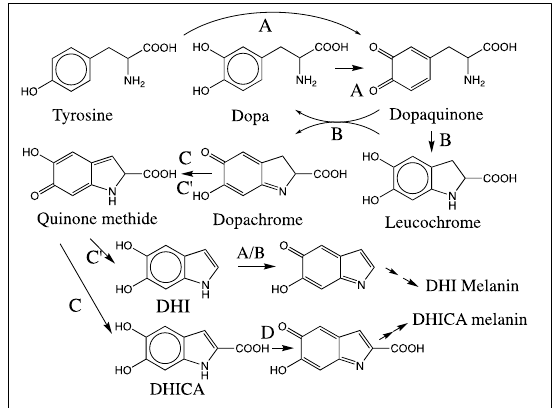
Figure 1. Simplified mechanism for eumelanin biosynthesis. Tyrosinase ( A ) oxidizes both tyrosine and dopa to dopaquinone. Dopaquinone undergoes a nonenzymatic intramolecular cyclization reaction to form leucochrome, which, following redox exchange with dopaquinone itself, produces dopachrome and dopa. Insect dopachrome decarboxylase/tautomerase ( C’ ) converts dopachrome to DHI. Mammalian dopachrome tautomerase ( C ) converts dopachrome to DHICA. In mammals, DHI seems to be produced nonenzymatically; in insects, DHICA is apparently not being formed. Oxidative polymerization of DHI and DHICA generates eumelanin pigment. B represents nonenzymatic